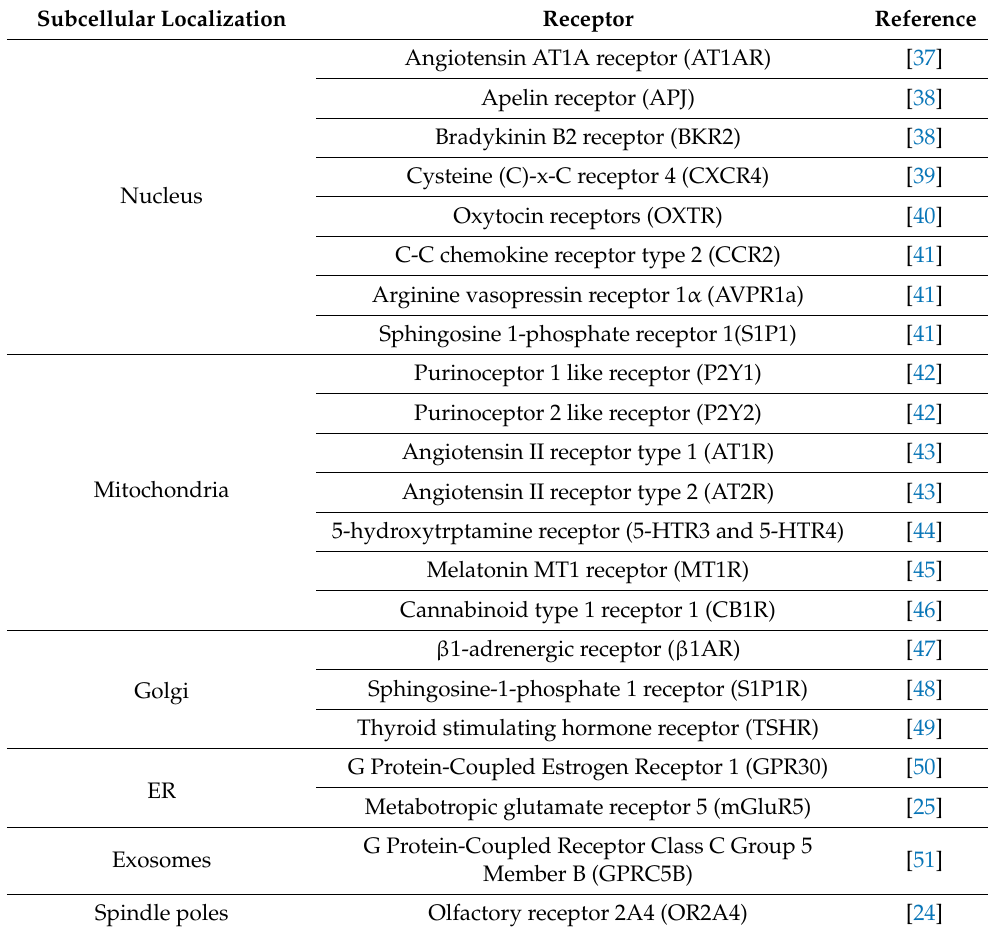
Table 1. Cont. Subcellular